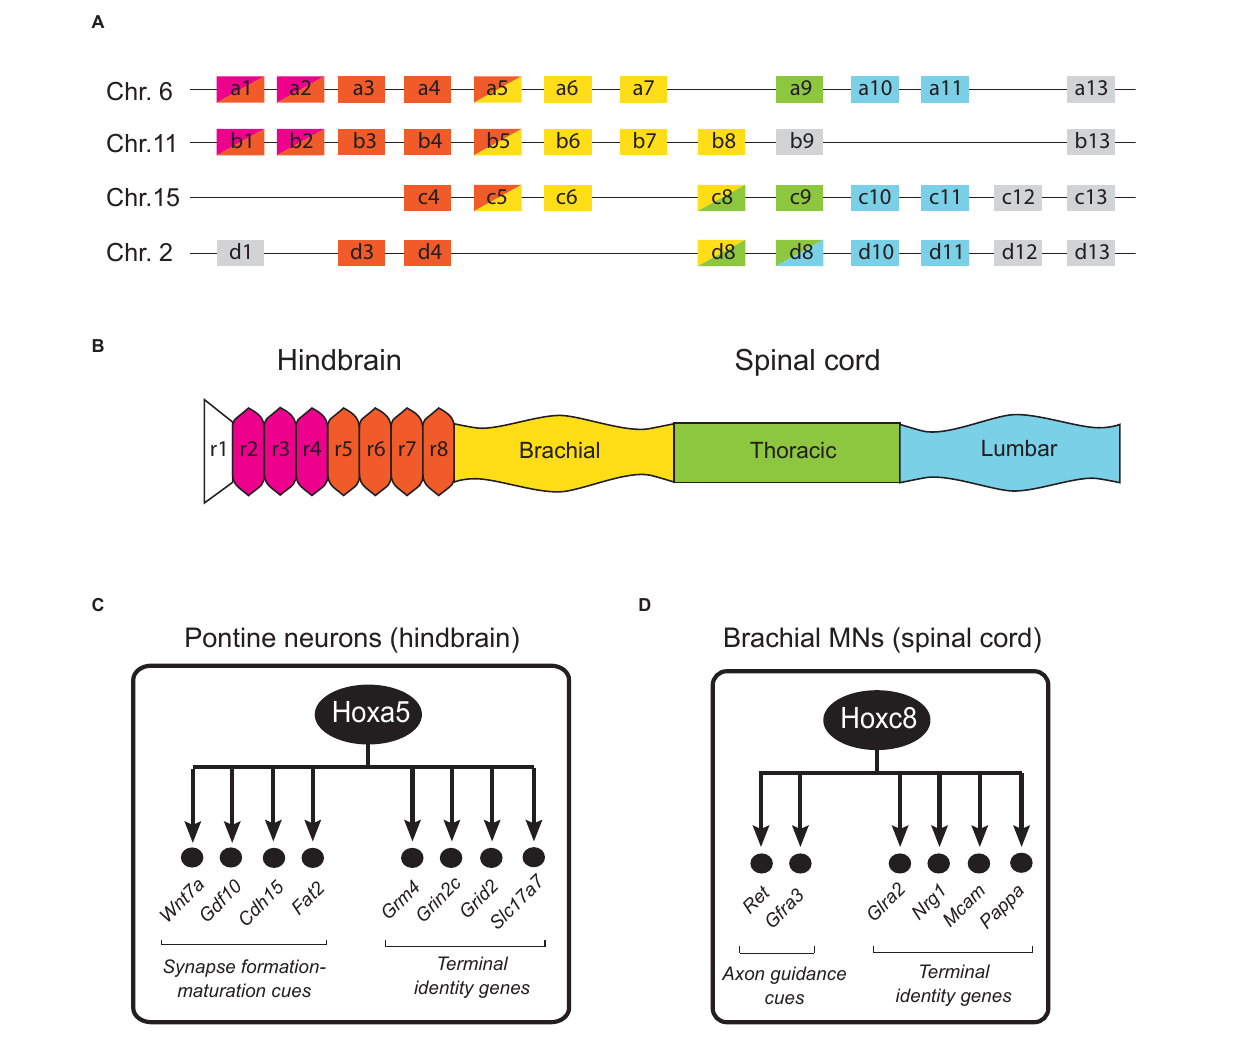
FIGURE 3 | Hox gene expression in the mouse hindbrain and spinal cord. (A) The 39 Hox genes in mice are distributed in four clusters (a, b, c, d). (B) Region-specific Hox gene expression is shown along the rostrocaudal axis of the embryonic nervous system. Adapted from Philippidou and Dasen (2013). The dynamic nature of Hox gene expression is not illustrated for simplicity. (C) Schematic summary of putative Hoxa5 target genes in pontine neurons. See text for details. (D) Schematic summary of Hoxc8 target genes in brachial MNs. See text for